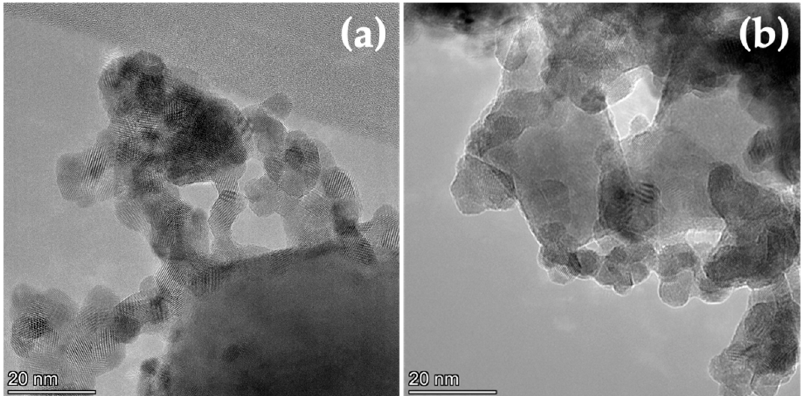
Figure 4. TEM images corresponding to the reduced NiOCeO 2 -8 ( a ) and NiOCeO 2 -10 ( b ) catalysts. After reduction treatment at 650 °C in H 2 (5%)/Ar, Ni appears as crystallites with dif- ferent sizes, in some cases reaching values of around 40–50 nm, as shown in Figure 4, for samples NiOCeO 2 -8 and NiOCeO 2 -10. In order to better identify the different phases and spatial distribution of Ni and Ce, HAADF-STEM images and composition STEM-EDS mappings have been recorded (Figure 5). Since the intensity of the HAADF-STEM images is proportional to the square of the atomic number of the element, the brightest areas in these images should correspond to the presence of Ce (Z = 58), and those of less intensity should correspond with the presence of Ni (Z = 28). However, because this intensity also depends on the thickness of the sam- ple, the difference in contrast is not always indicative of the element’s distribution. There- fore, the corresponding STEM-EDS maps for the areas observed in the HAADF-STEM images have also been recorded. The combination of both techniques reveals the existence of Ni aggregates of different sizes and morphologies surrounded by CeO 2 . The images confirm the presence of Ni particles with a high heterogeneity in size, although the limited number of images recorded did not permit reliable size distributions to be obtained. It should be pointed out that, according to the results derived from H 2 -chemisorption stud- ies, these distributions would be shifted towards larger particle size values in the case of sample NiOCeO 2 -10. Figure 5. HAADF images and EDS mappings corresponding to the reduced NiOCeO 2 -8 ( left ), Ni- OCeO 2 -9 ( center ) and NiOCeO 2 -10 ( right ) catalysts.